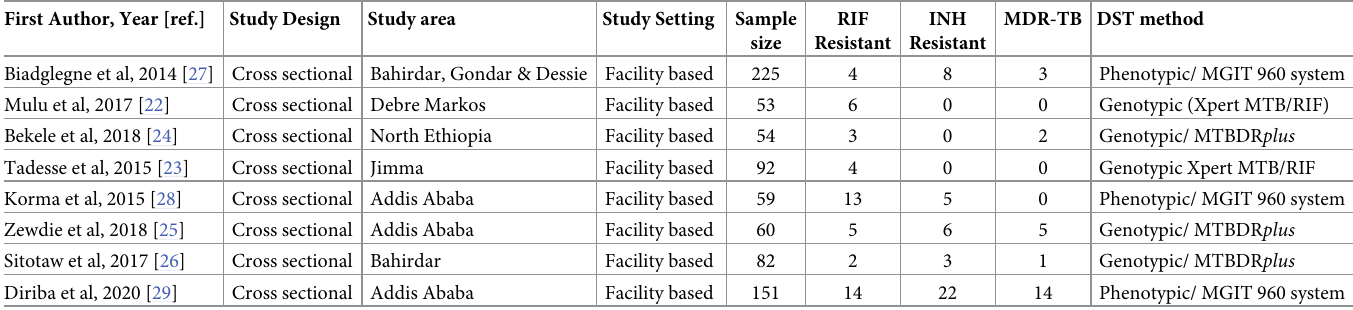
Table 1. General characteristics of studies included in the review.